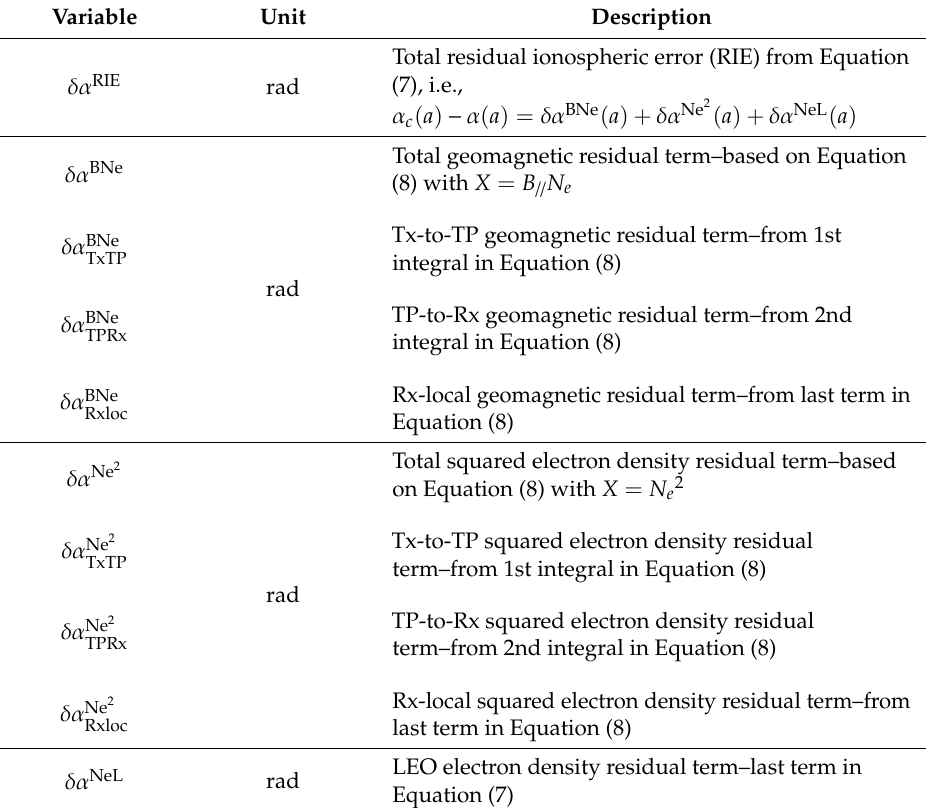
Table 4. Outputs of the bi-local correction approach as integrated in the